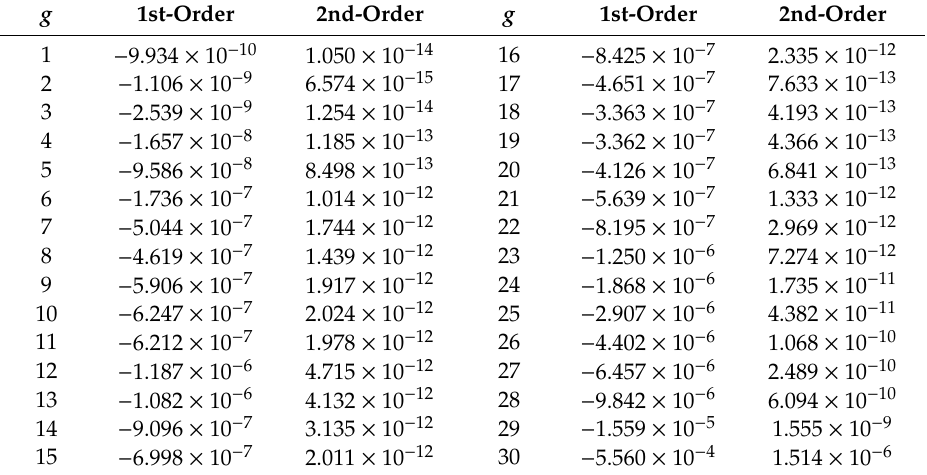
Table 23. Comparison of 1st-order relative sensitivities and 2nd-order relative sensitivities cross sections for isotope 5 (C).